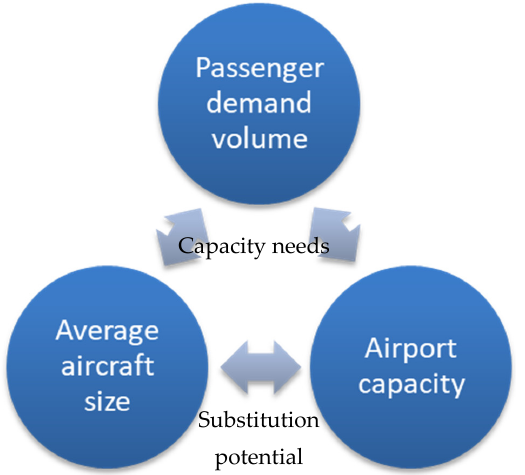
Figure 4. Relationship between passenger demand, airport capacity, and aircraft size [own illustra- tion].